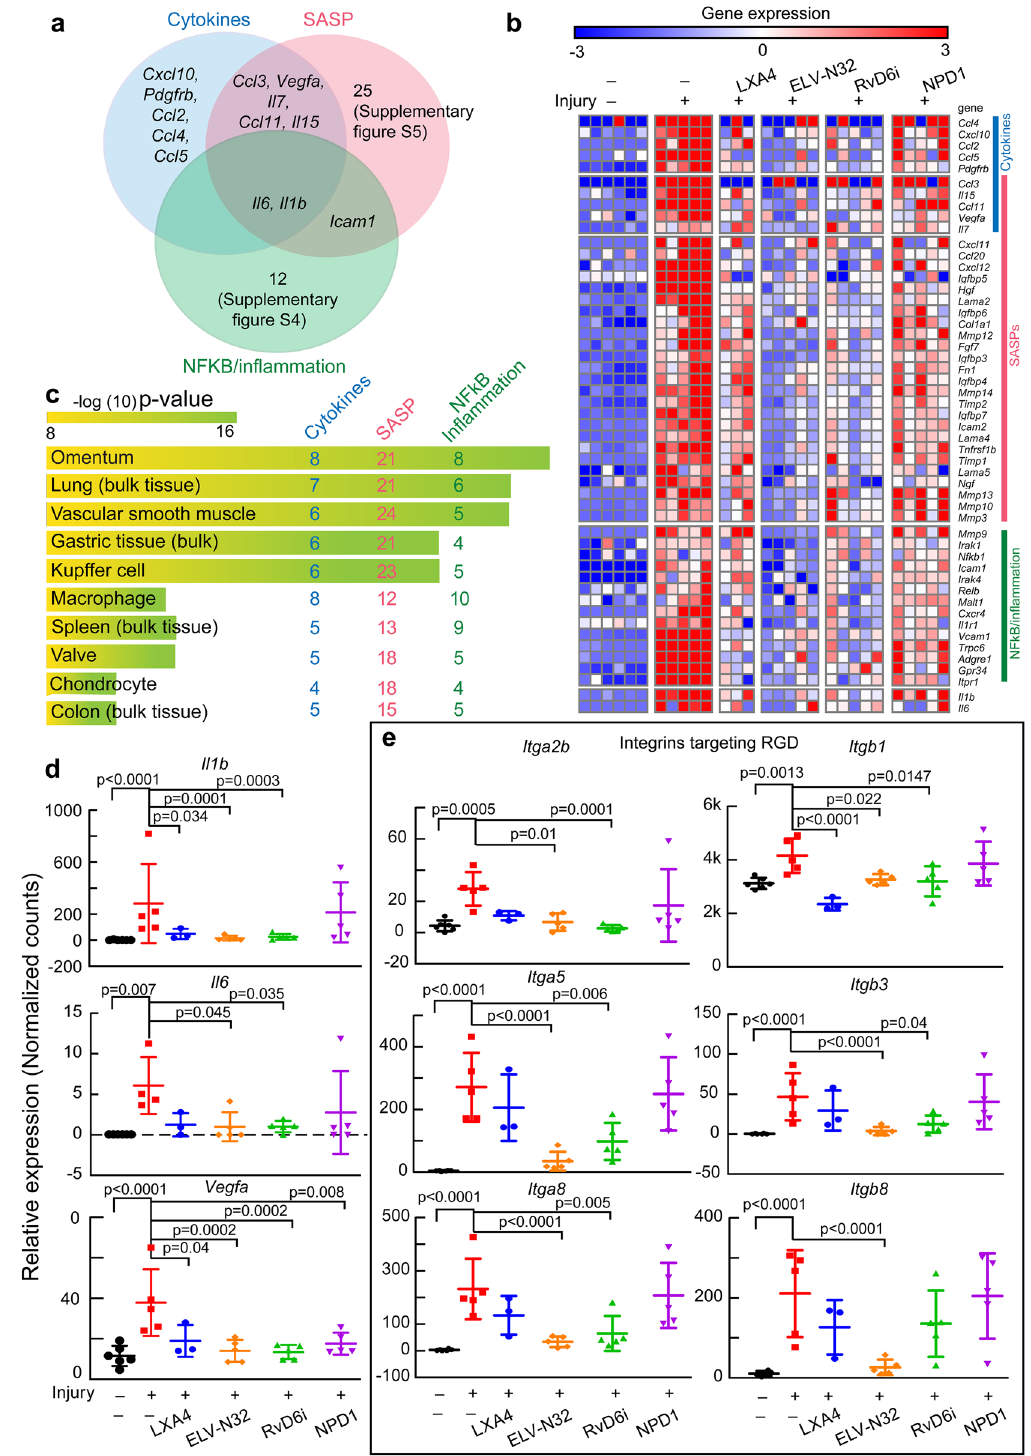
Figure 3. Lipid mediators down-regulate injury-induced gene expression of NFkB/inflammation, senescence- associated secretory phenotype, and pro-inflammatory cytokines after cornea injury. ( a ) Venn diagram of cytokines, SASP, and NFkB inflammatory genes upregulated by injury. ( b ) Heatmap of normalized counts data. Each small square represents data from one cornea. There are 51 genes increased by injury, and most are inhibited by ELV-N32 and RvD6i treatment. ( c ) The ArchS4 human tissue analysis prediction for the 51 genes. The length of the bar represents the significance of the gene set in the tissues, while the lighter the color, the higher the significance. The numbers show the genes from the denoted group enriched in each pathway. ( d ) Scatter plots of Il1b , Il6 , and Vegfa genes. ( e ) Scatter plots of genes that encode proteins that target RGD. The p-value of ANOVA-post hoc Dunnett’s multiple comparisons test with vehicle as reference are shown. Mean and SD are depicted as the lines. The normalized counts were used for analysis. The protein level of IL1B and VEGF were confirmed using Jess capillary-based western assay (Supplementary Fig.